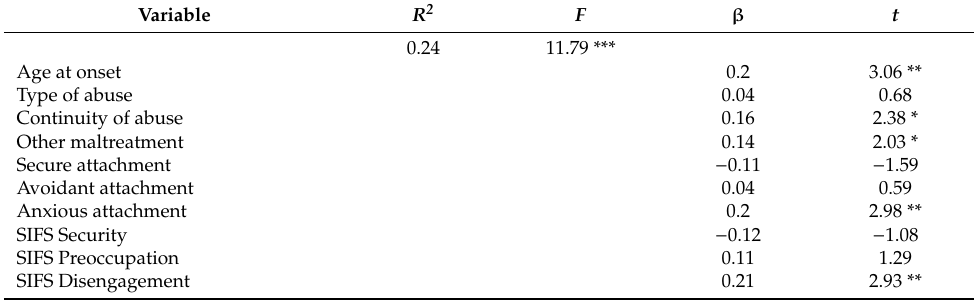
Table 5. Regression analysis of suicidal ideation at the time crisis as a function of the characteristics of the abuse, the existence of other maltreatment, attachment, and security in the family system ( n = 188). Variable R 2 F β